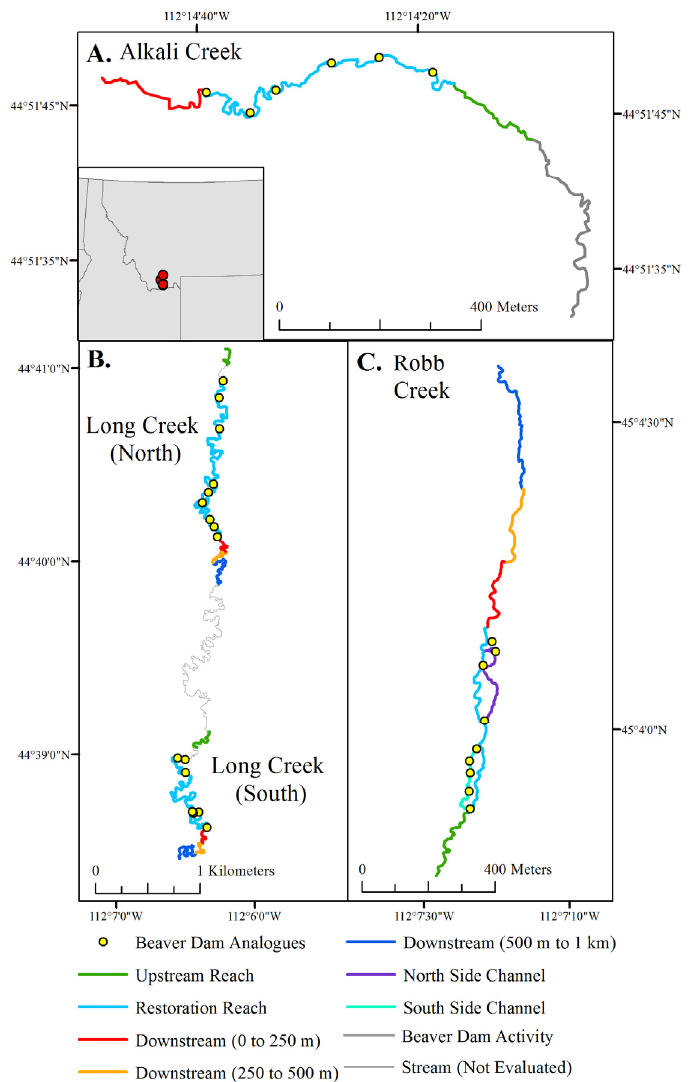
Figure 3. A schematic of ( A ) Alkali Creek, ( B ) Long Creek (North and South), and ( C ) Robb Creek, indicating the reaches along each of the stream sites that were analyzed, relative to the distribution of the beaver dam analogues. Flow direction can be determined from the relative location of the upstream and downstream reaches.